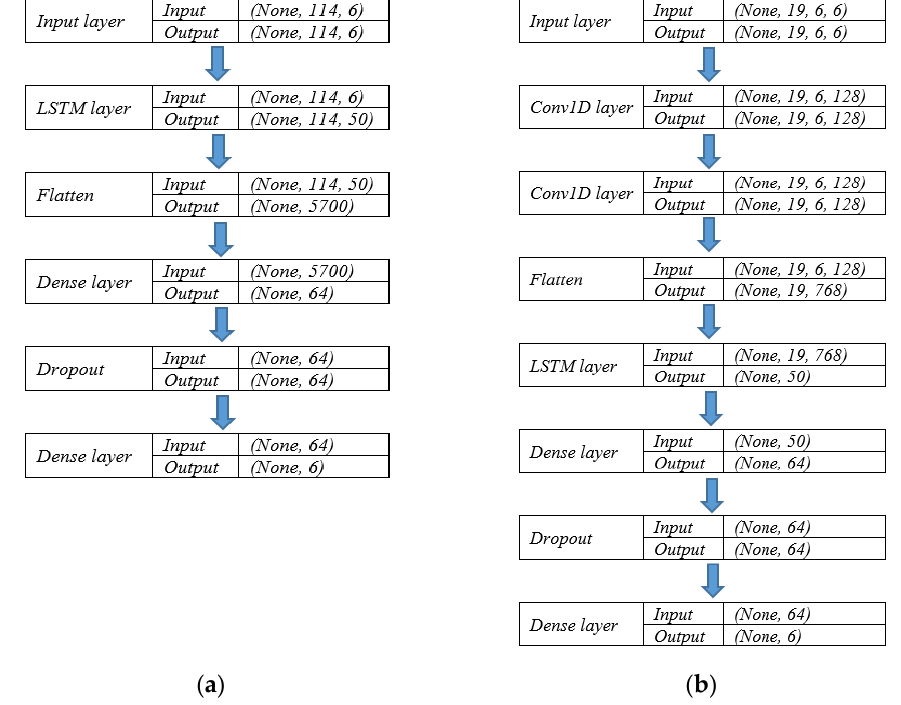
Figure 6. Model configurations. ( a ) conventional LSTM; ( b ) CNN-LSTM.